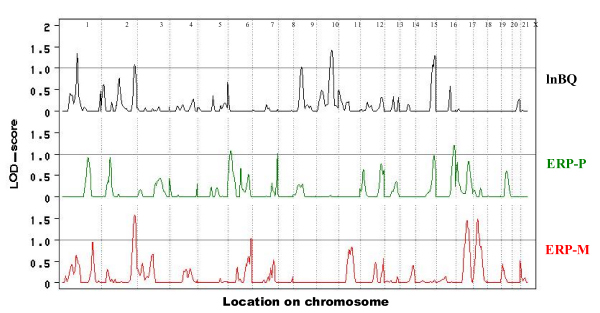
LOD score results for lnBQ, ERP-P and ERP-M (first pass). For the autosomes the x-axis shows map location in cM and for the X chromosome the markers numbered 1–13.